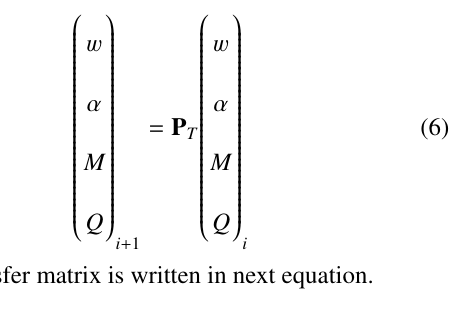
Fig. 5. Second torsion and fourth bending mode during immer- sion, simulation data